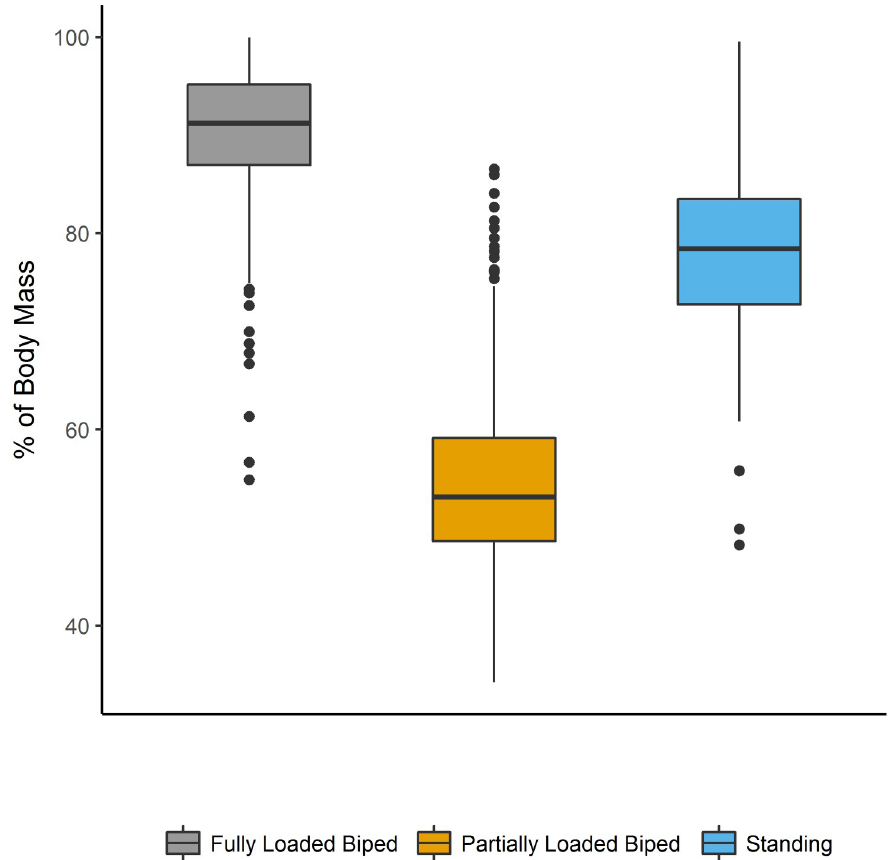
Fig 2. Mean hindlimb loading for each experimental group. Boxplot of the mean amount of load experienced by the hindlimbs (as a percentage of body mass) in each experimental group. The horizontal lines indicate the median (of the daily loading means), the outer boundaries of the box represent the interquartile range, the whiskers indicate the minimum and maximum, respectively, and the individual points represent outliers. Data are from each 60-minute period over the twelve week experiment. All comparisons are significantly different (p < 0.001). Reprinted from Foster [45] under a CC BY license, with permission from Foster, original copyright 2018. Figure available at https://doi.org/ 10.6084/m9.figshare.5462065.v4 under a CC-BY 4.0